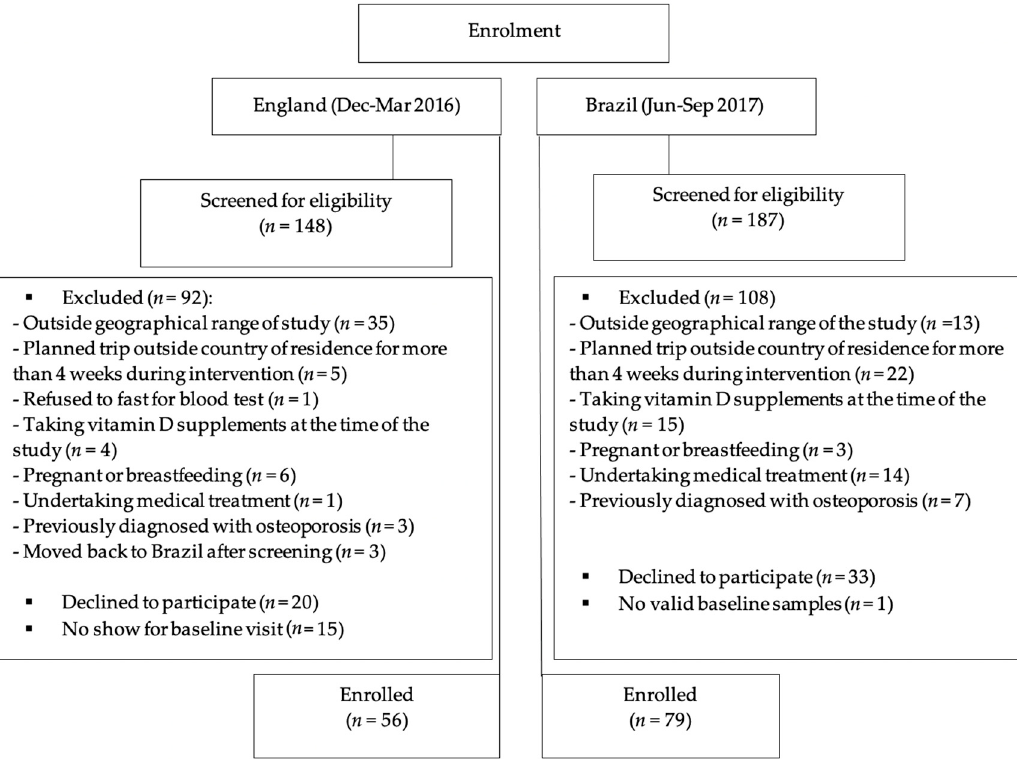
Figure 1. Flow diagram of participant enrolment.